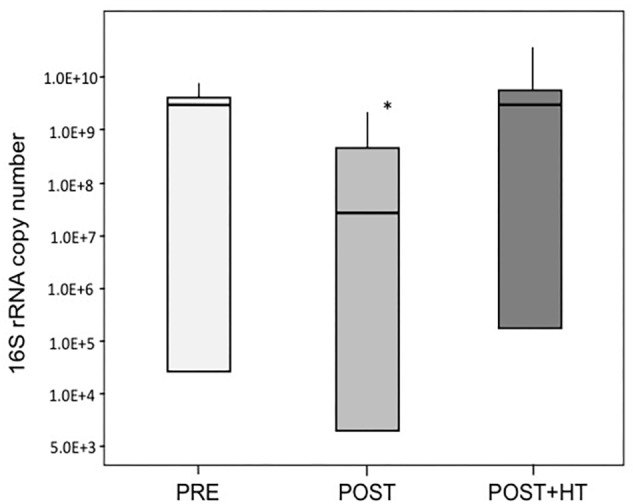
Average 16S rRNA gene copy number in samples of women in the three treatment groups. One group (PRE) included only premenopausal women with a vaginal pH ≤ 5 and vaginal atrophy score ≤2. The second group (POST) included only postmenopausal women with a vaginal pH ≥ 5 and vaginal atrophy score ≥6, while the third group (POST+H) included postmenopausal women undergoing hormone replacement therapy who had a vaginal pH ≤ 5 and a vaginal atrophy score ≤2. Asterisk denotes statistically significant difference (P < 0.05), medians are indicated by thicker lines within the bar graph for each group of women.